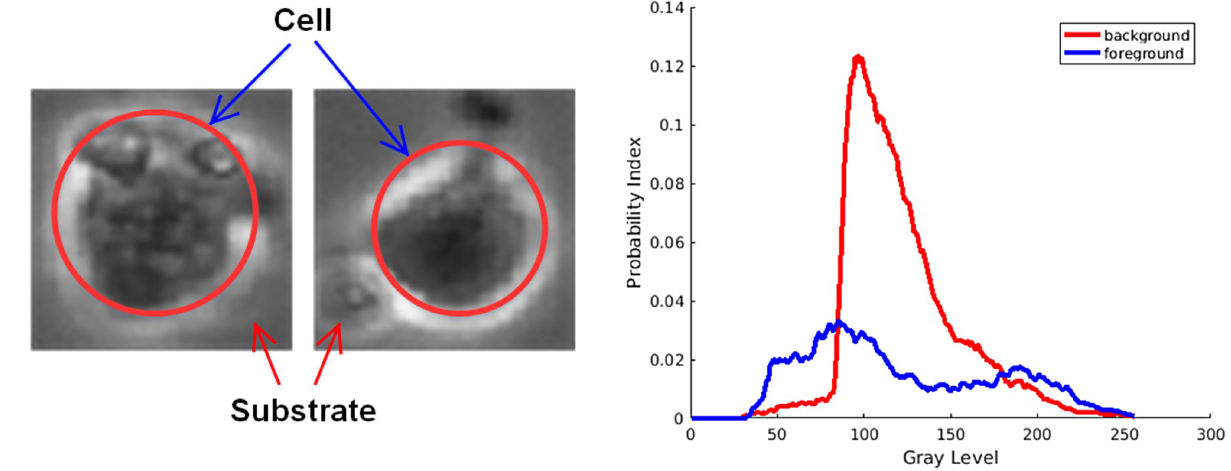
Fig 6. Images of the cell body and the substrate and their corresponding intensity